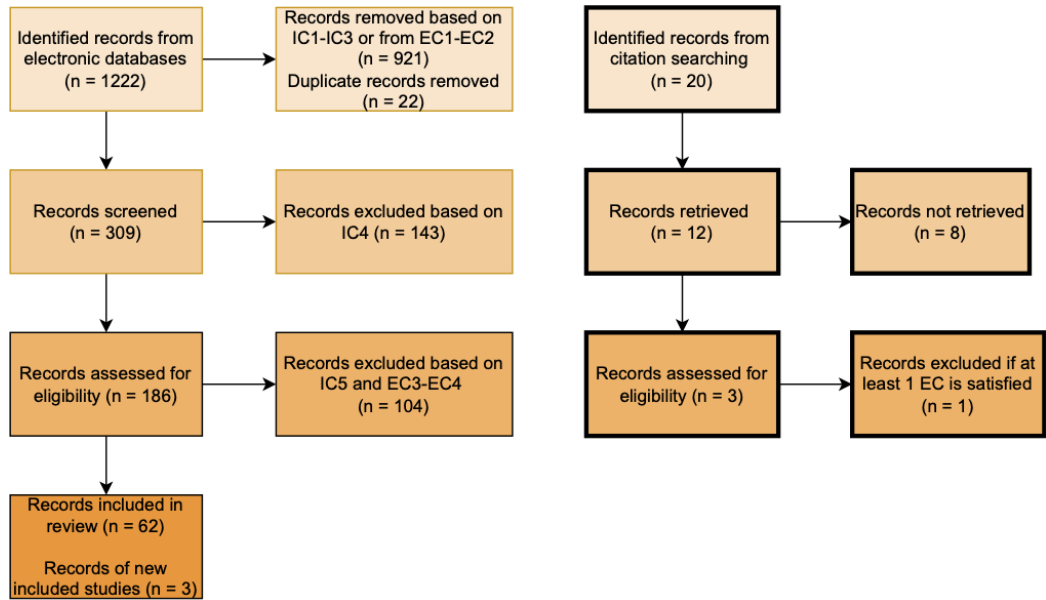
Figure 1. Systematic review flow diagram.